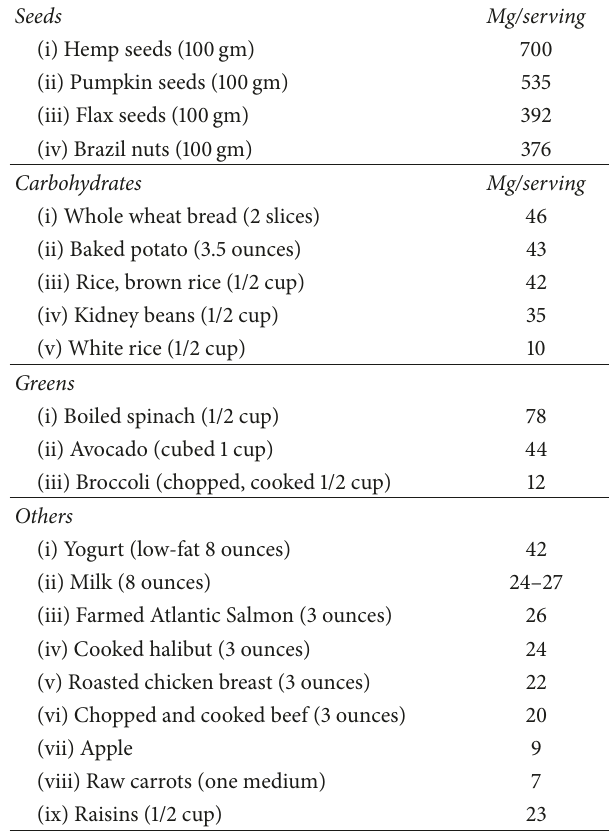
Table 7: Common food sources of magnesium (in mg per serving or 100